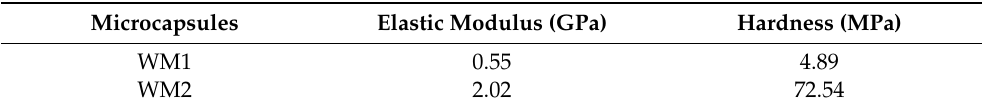
Table 7. Elastic modulus and hardness of